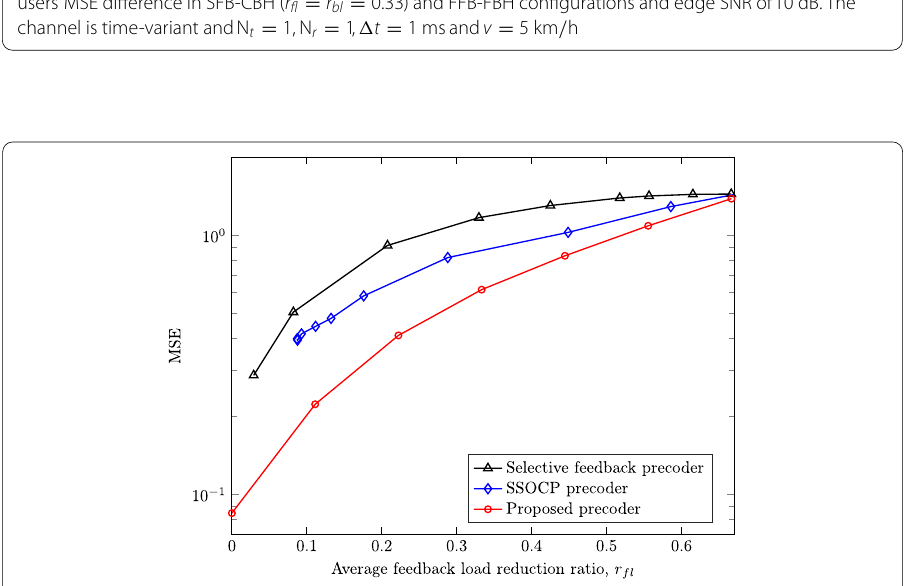
Fig. 9 Performance comparison of the proposed scheme with selective feedback and SSOCP based relative thresholding precoders in edge SNR of 10 dB in time-variant